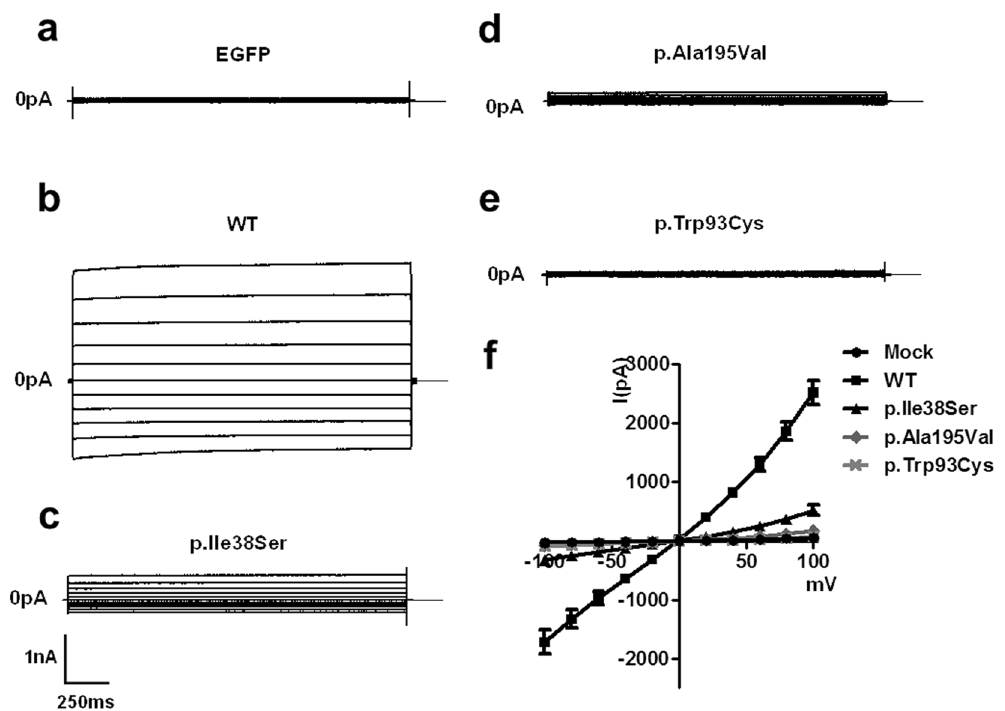
Figure 4. p.Ile38Ser BEST1 mutant shows smaller currents compared to wild type (WT) BEST1 and bigger currents compared to p.Ala195Val or p.Trp93Cys mutants. (a–e) Representative traces of HEK293T cells transfected with EGFP alone (a) , WT (b) , p.Ile38Ser (c) , p.Ala195Val (d) , or p.Trp93Cys (e) BEST1. Voltage was stepped from a holding potential of 0 mV to between − 100 and + 100 mV in 20 mV steps. Step duration was 2000 ms. (f) Current-voltage relationship of mock, WT, and mutant BEST1. Data are presented as mean ±